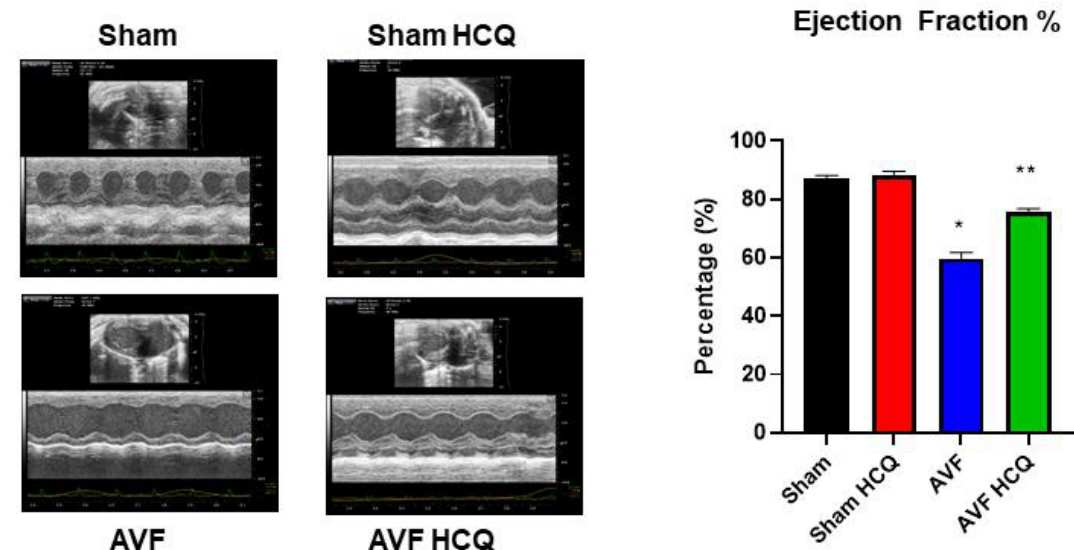
Figure 9. Representative scans of echocardiography; the bar graph represents % ejection fractions (EFs) of hearts from AVF and sham mice with and without the HCQ treatment. *, <0.05 compared with sham, **, <0.05 compared with AVF; n = 5–8 in each group.